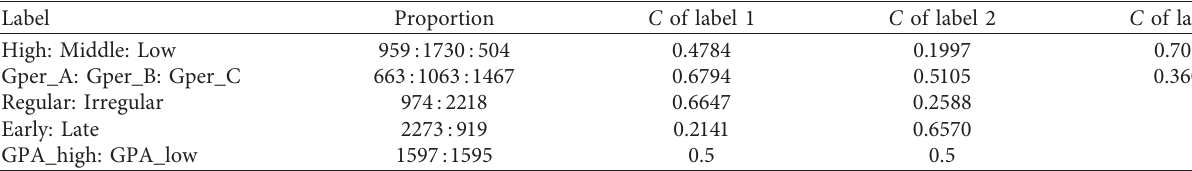
Table 6: The result of C .